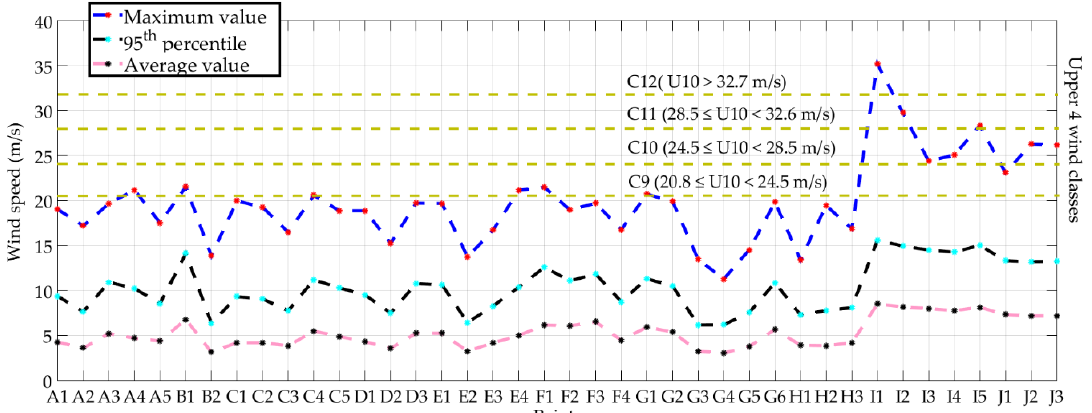
Figure 4. Distribution of the U10 wind speed in the sites considered, as resulting from the analysis of the ECMWF ERA-Interim dataset for the time interval 1983–2017. The data were processed in terms of maximum values, 95th percentile, and average values in comparison to the upper four wind classes (C9–C12) of the Beaufort scale.